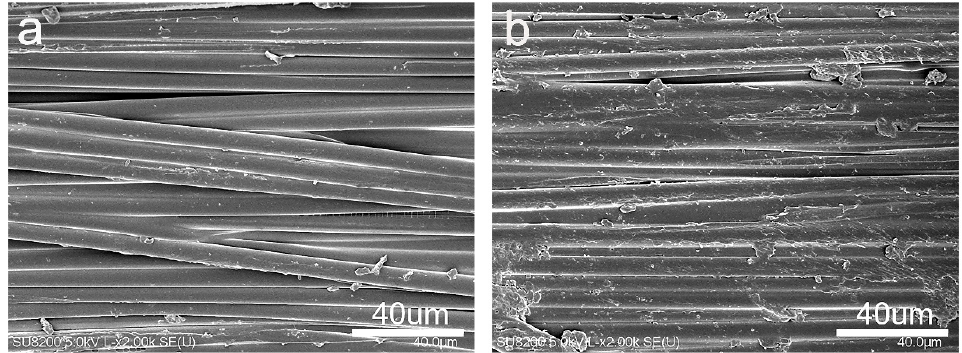
Figure 11. SEM morphologies of ILSS fracture surface of composite: ( a ) Untreated CF and ( b ) CF- KHN + -4GO.